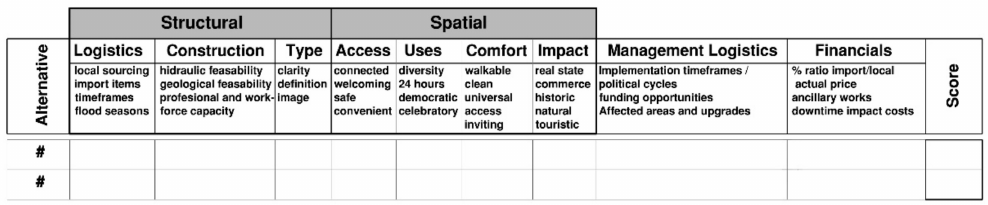
Figure 6. Comparative charts were used to evaluate alternatives, as an indicative tool